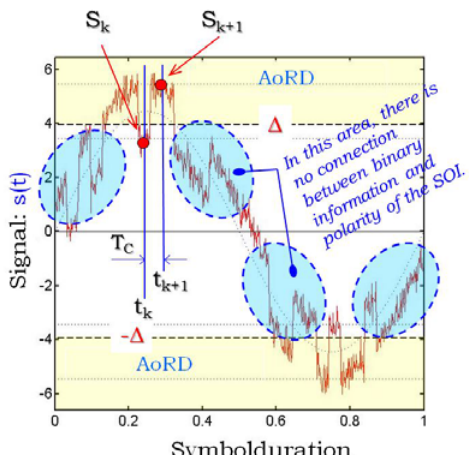
Fig. 1. Received signal at baseband with dominating CW-interference. SOI ... PN-sequence, SONI .... AWGN plus CW. AoRD ... Area of Reliable Decisions, S k ... sample at time instant t k , ± Δ ... symmetric magnitude